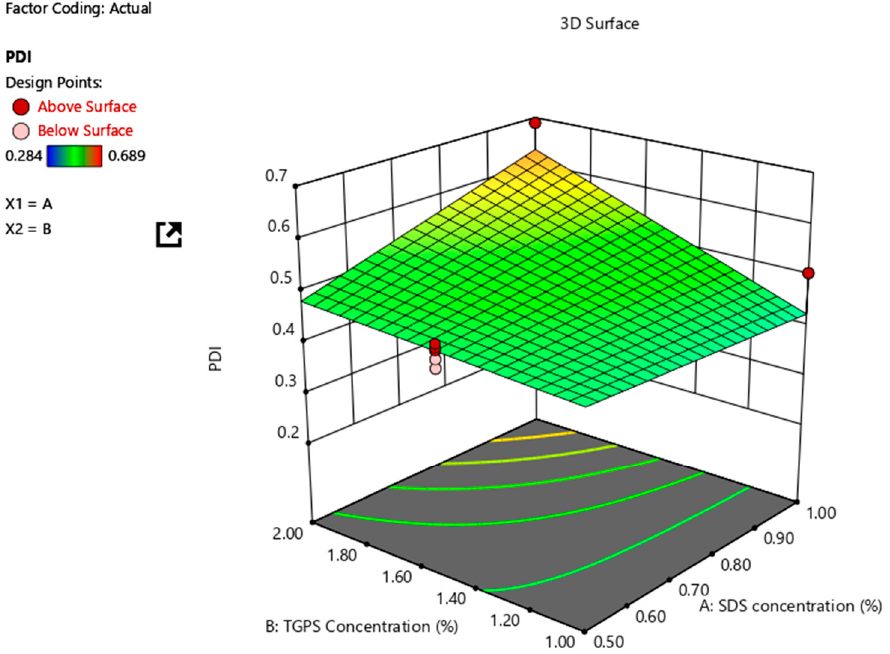
Figure 1. 3D response surface plot depicting the impact of SDS and TPGS 1000 concentration on particle size of the NCC.